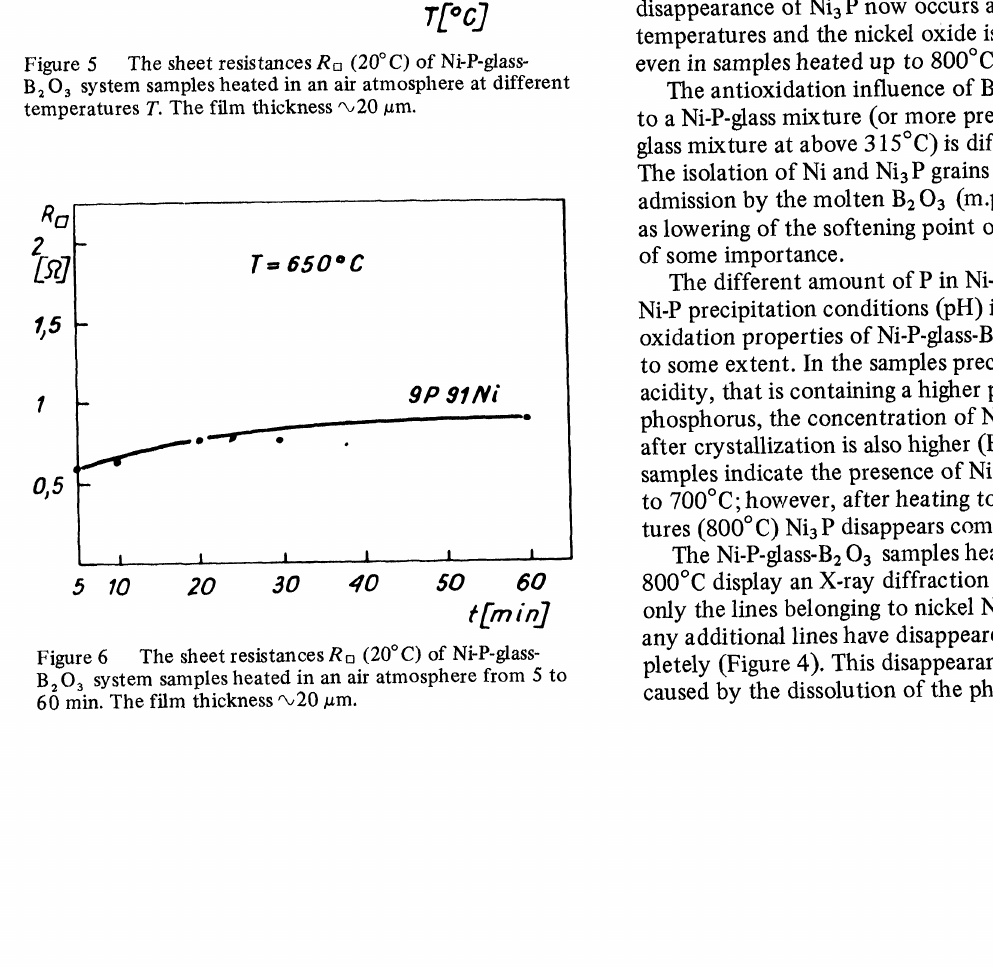
Figure 6 The sheet resistances R (20 C) of Ni-P-glass- B2 O3 system samples heated in an air atmosphere from 5 to 60 min. The film thickness 20